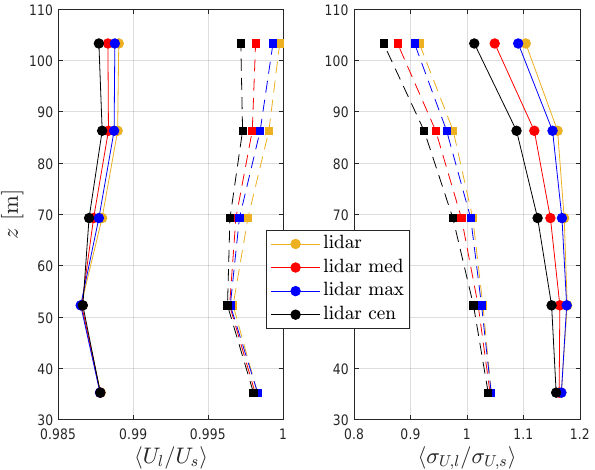
Figure 9. ZX lidar to cup anemometer ratio averaged over all 10-min periods and 20 turbulence boxes of the mean ( left ) and standard deviation ( right ) of the horizontal velocity. The solid and dashed lines correspond to the floating and fixed lidars, respectively. The results ‘lidar’ (in the legend) correspond to those without accounting for the probe